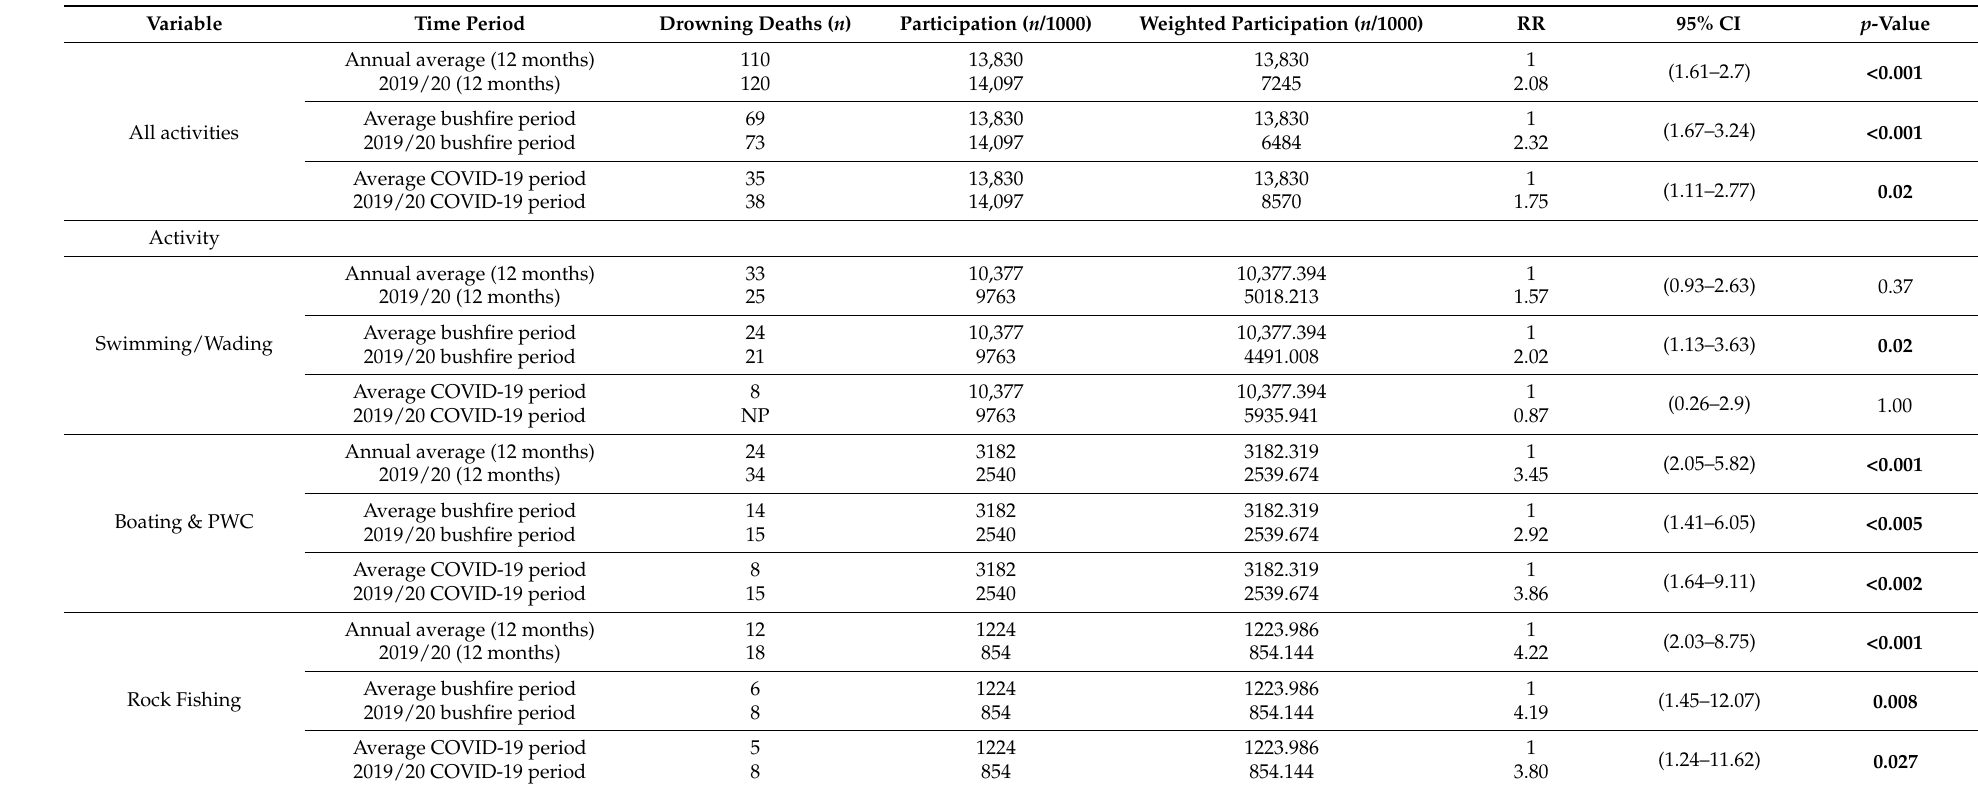
Table 3. Relative risk analyses for test periods of overall coastal drowning and the top three coastal